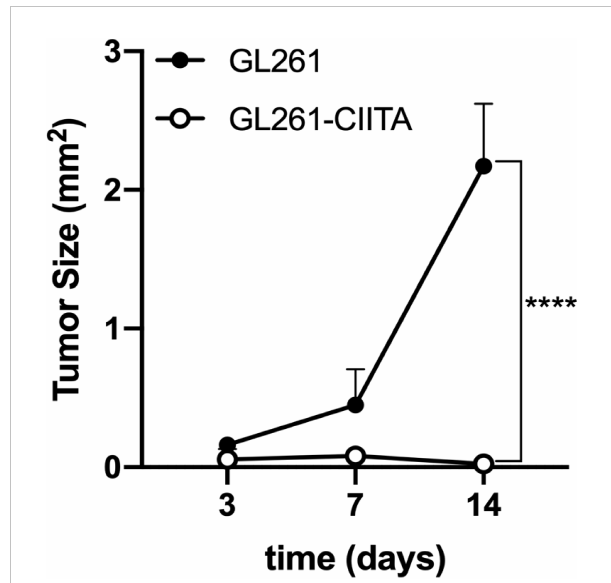
FIGURE 4 GL261-CIITA tumors are strongly retarded in their growth in vivo. C57BL/6 mice received intracranial injection of 3 × 10 4 GL261 or GL261-CIITA glioma cells. On days 3, 7, and 14 after injection, mice were sacri fi ced, brains were removed, and tumor size was measured as indicated in the Materials and Methods section. Points represent the average tumor size as mean values, and error points indicate the SD of each group at different time points. p -Values were determined via unpaired t-test. On day 14, GL261 parental tumors were at least 100 times larger than GL261-CIITA tumors (n = 4, *** *p <